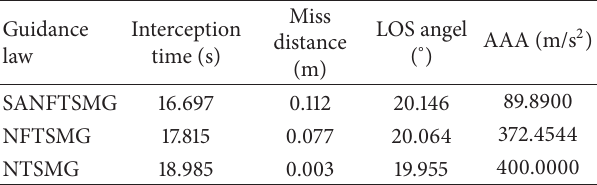
Table 2: Summary of simulation results in Case 1 .